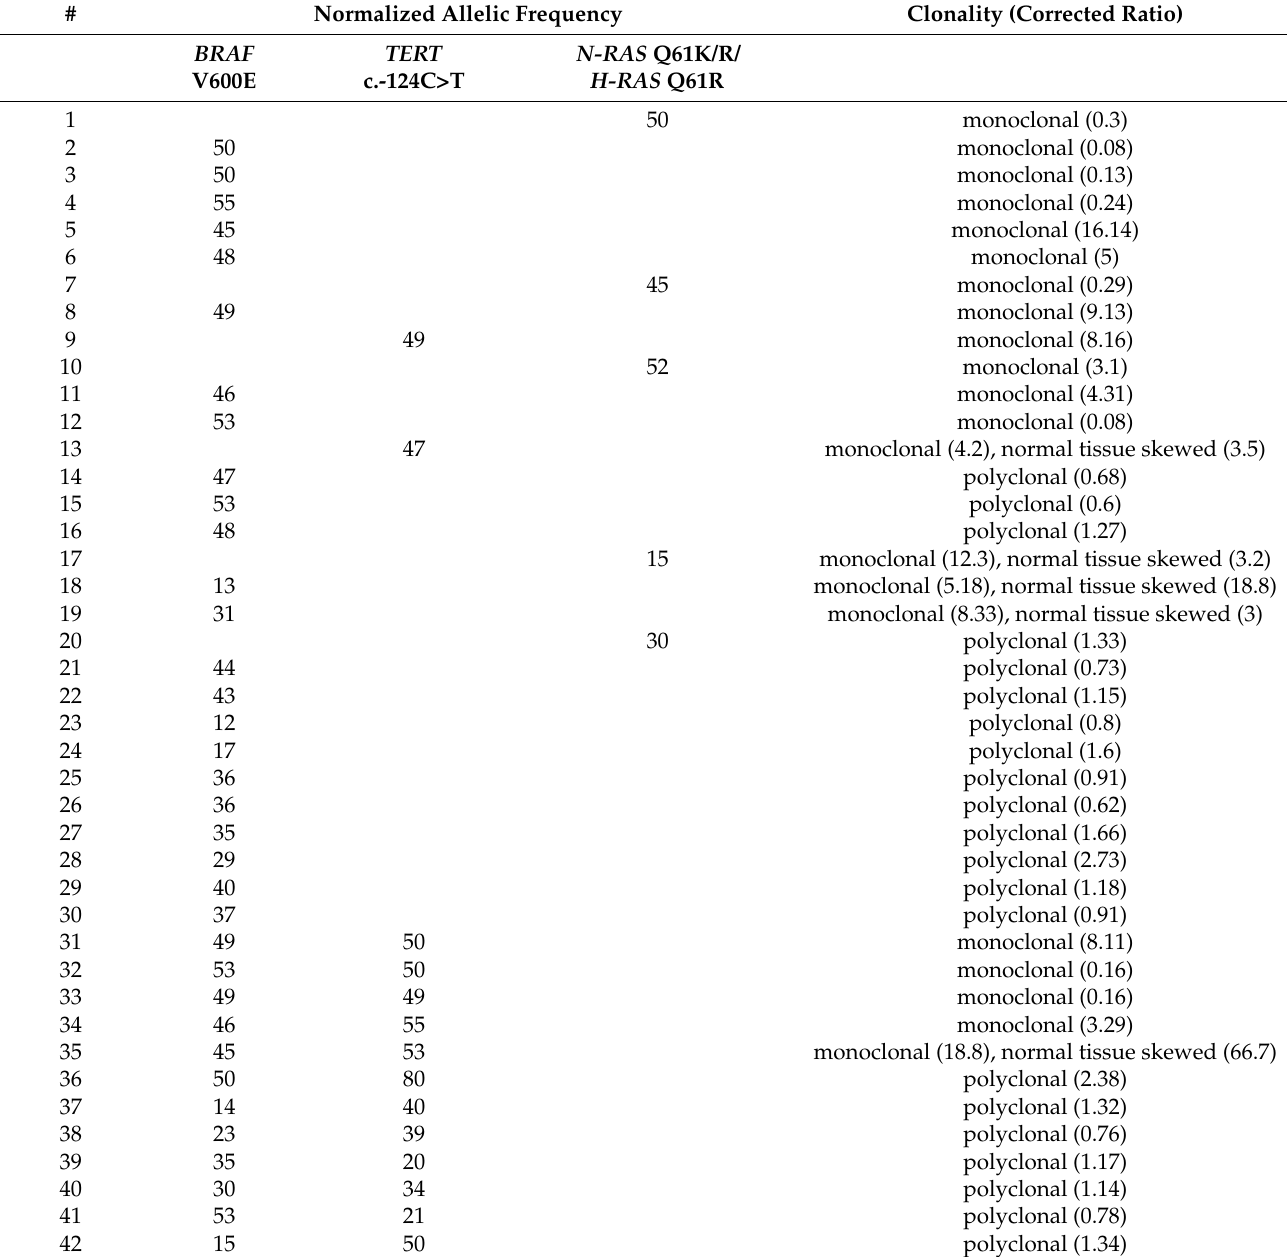
mutations, one (#36) had NAF 50% and 80%, respectively, and six had NAF < 45% for one or both mutations. Table 1. Normalized allelic frequencies of mutations detected by the MassARRAY panel and clonality status identified by the HUMARA assay in 42 PTCs. Tumors 1–16: single mutation with normalized allelic frequency (NAF) 50 ± 5%, tumors 17–30: single mutation with NAF < 45%, tumors 31–36: double mutations with NAF 50 ± 5%, tumors 37–42: double mutations, with at least one with NAF < 45%. Cases 13, 17, 18, 19, 35: non-random (skewed) X-inactivation detected in the contralateral normal tissues. #,